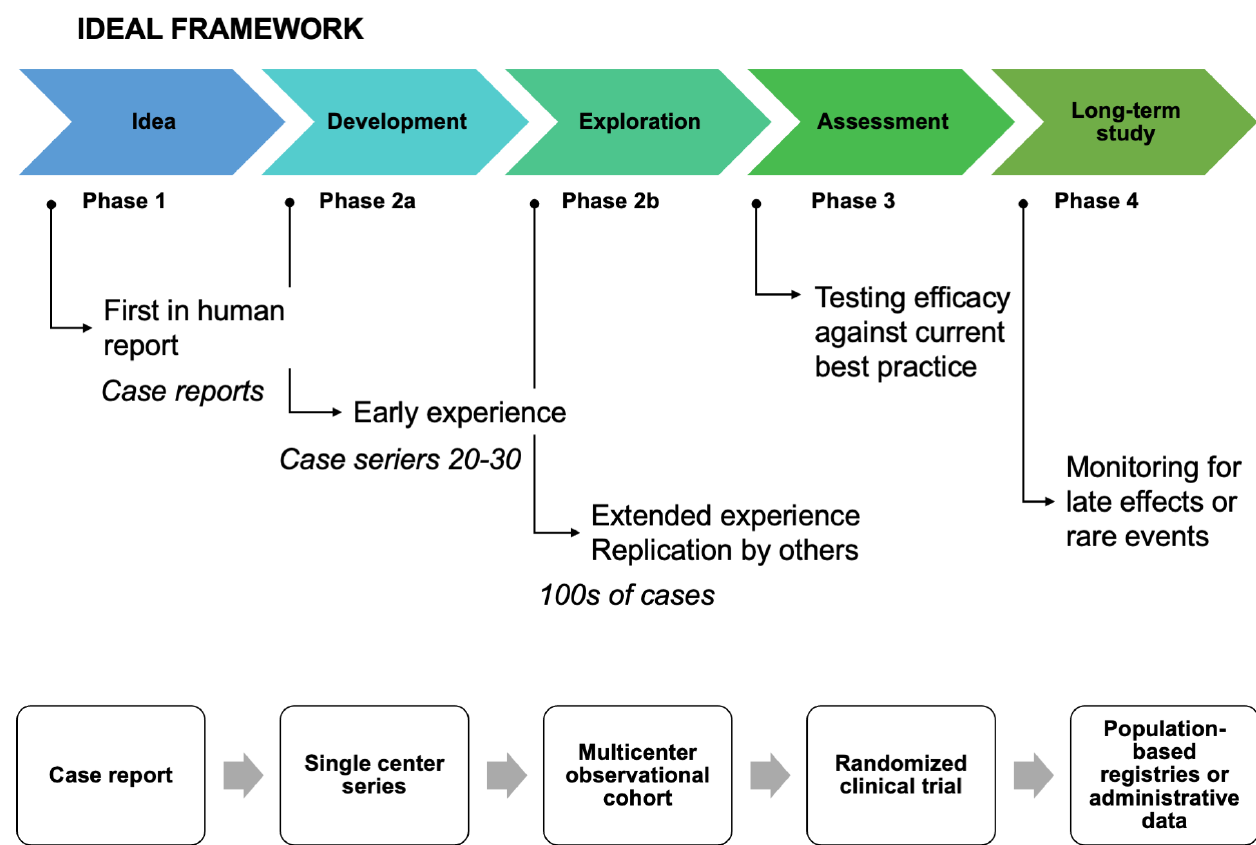
Figure 2. The IDEAL framework.